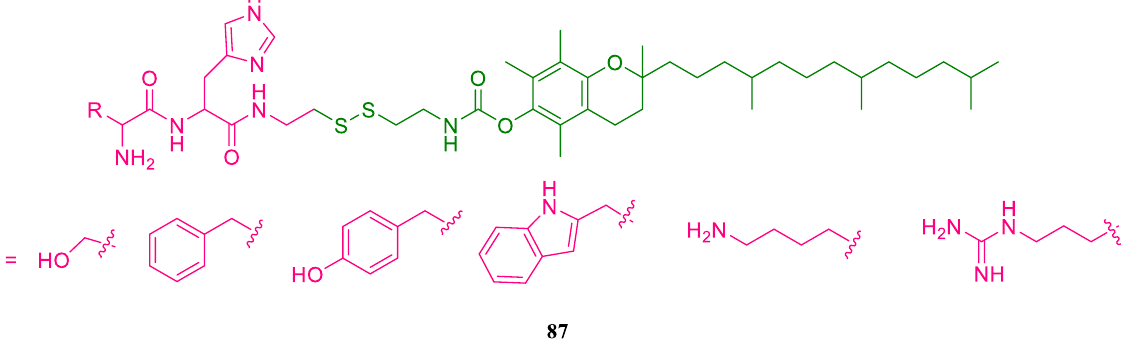
Figure 71. Tocopherol-based cationic lipids conjugated to peptides.